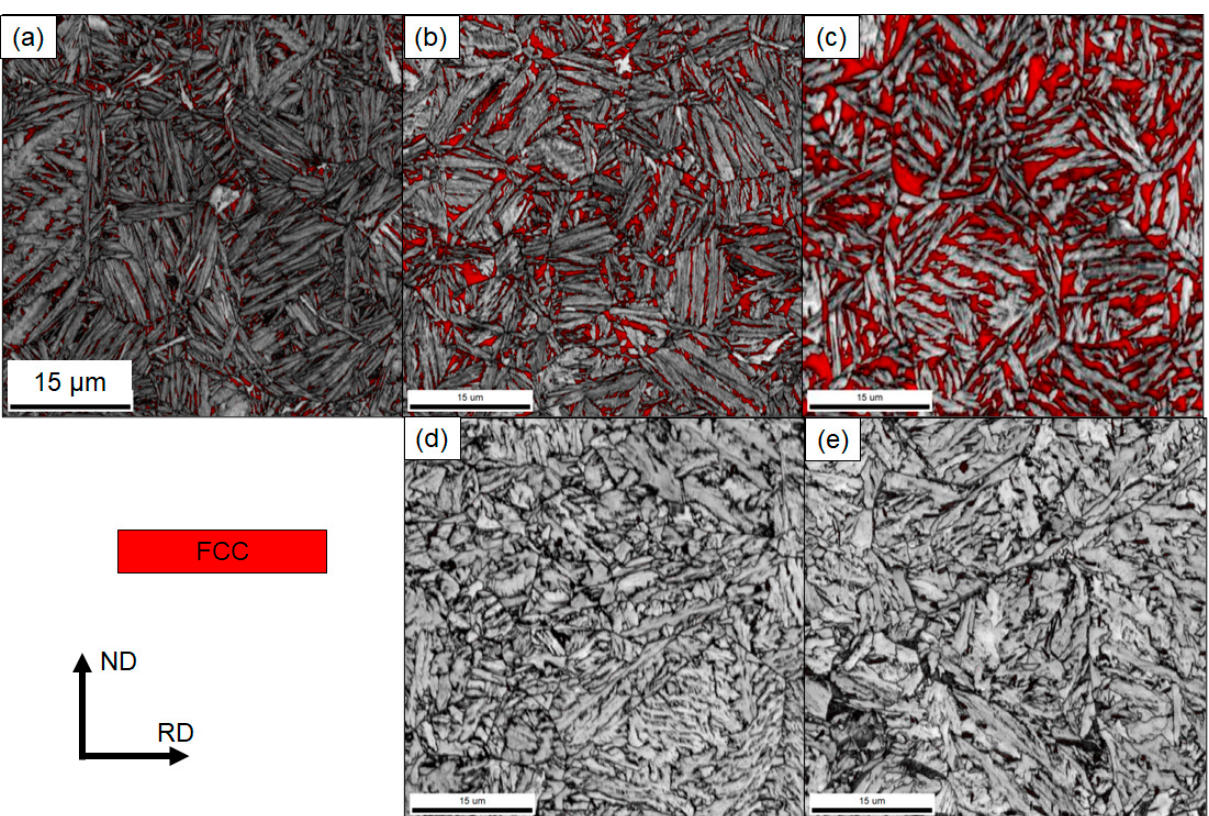
Figure 6. Image quality (IQ) map with overlayed phase coloring, where red regions are FCC austenite. The samples are after the heat treatment at ( a ) 573 K for 1.8 ks, ( b ) 623 K for 1.8 ks, ( c ) 673 K for 1.8 ks, ( d ) 723 K for 3.6 ks, and ( e ) 773 K for 1.8 ks.